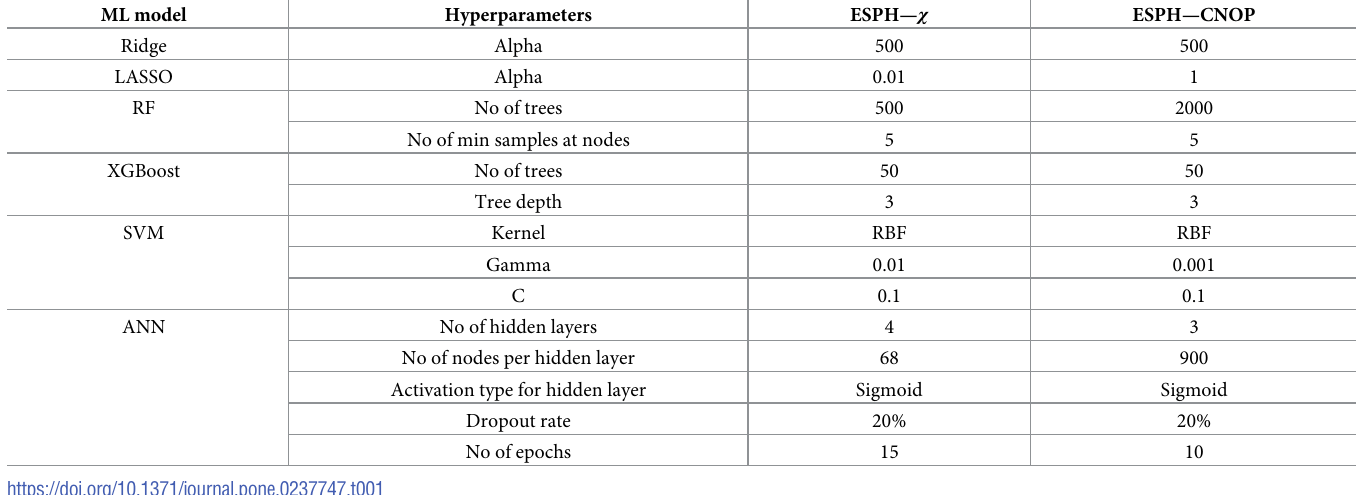
ffiffiffiffiffiffiffiffiffiffiffiffiffiffiffiffiffiffiffiffiffiffiffiffiffiffiffiffi P n